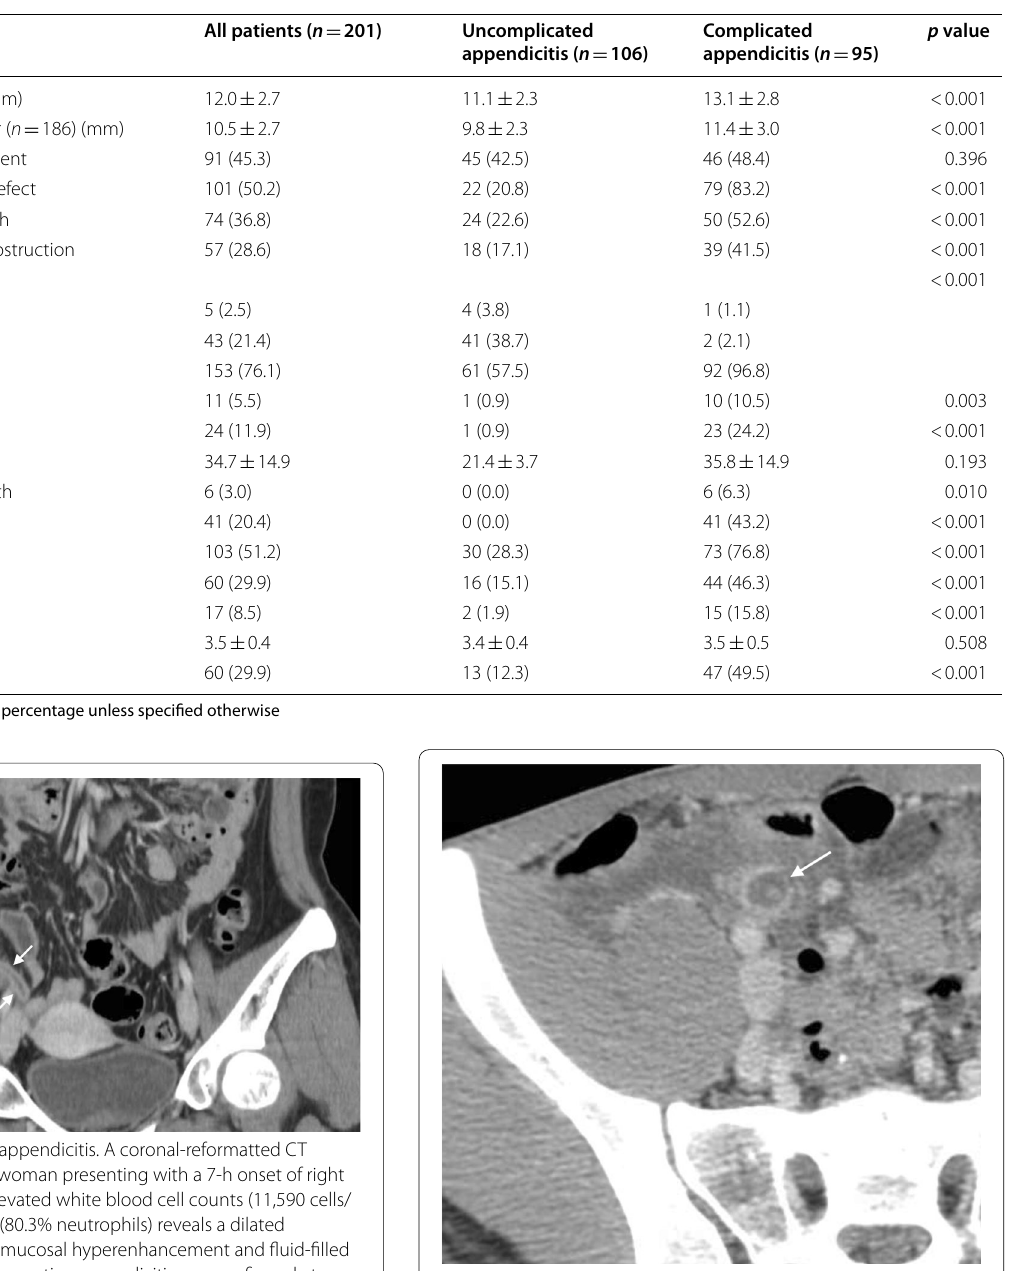
Fig. 3 Mucosal enhancement defect of appendix. An axial CT image of a 20-year-old man presenting with a 9-h onset of right lower quadrant pain, elevated white blood cell counts (19,150 cells/ mm3) and neutrophilia (85% neutrophils) shows a dilated appendix with focal defect at the anteromedial wall ( arrow ). Gangrenous appendicitis was confirmed at surgery and